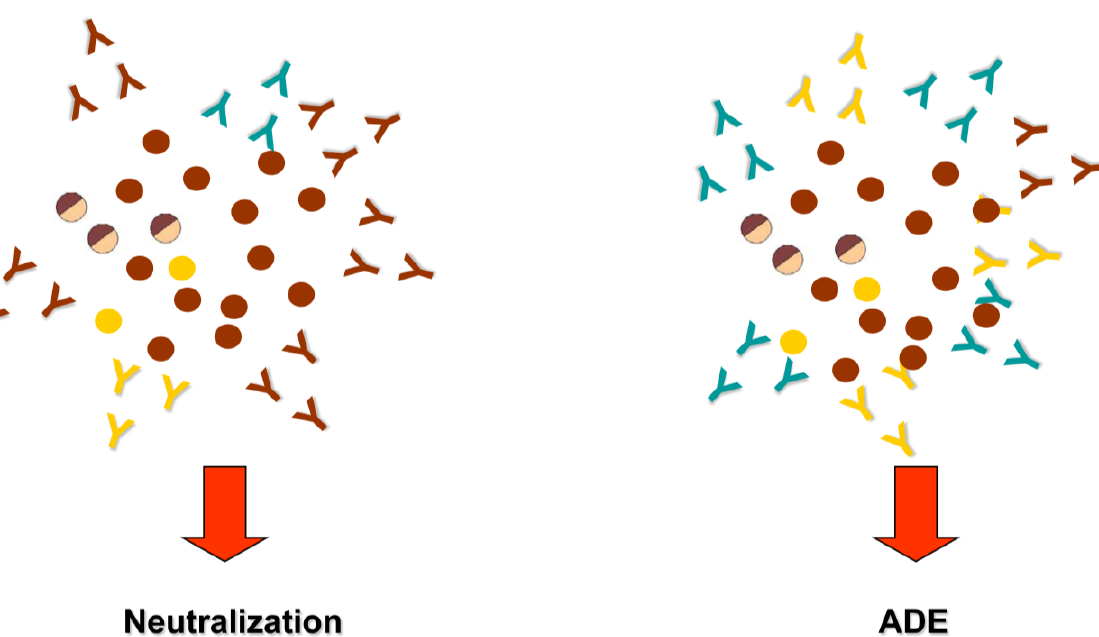
Figure 1. Schematic representation of viral populations and anti-E and anti-prM antibodies involved in neutralization and ADE mechanism. Immature ( ), partially mature ( ), mature ( ) viral particles, neutralizing anti-E antibodies ( Y ), cross-reactive